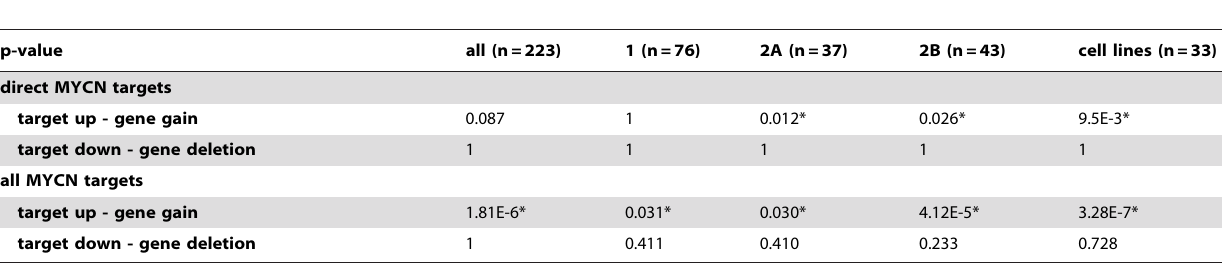
Table 1. Enrichment analysis for (direct) MYCN target genes in focal aberrations in the clinico-genetic neuroblastoma tumor subgroups and cell